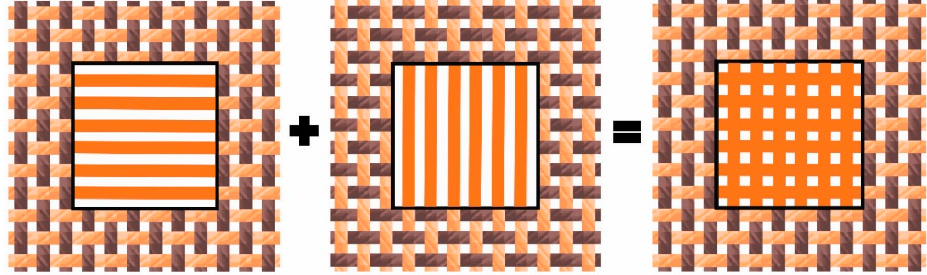
Figure 5. Schematic representation of the preparation of double-layer samples.